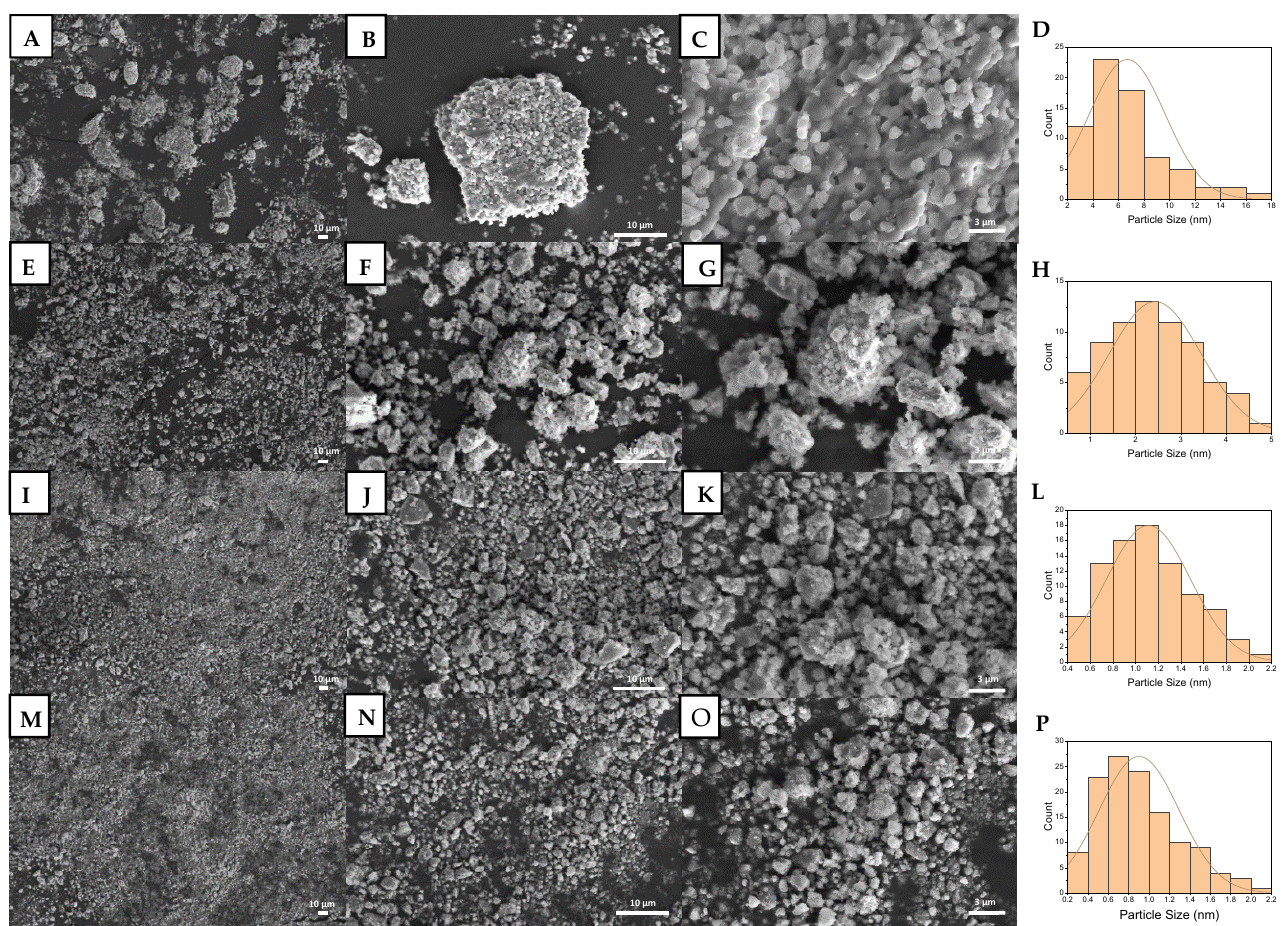
Figure 2. SEM images and particle size distribution of unmilled BHA ( A – D ), BHA milled for 3 h ( E – H ), BHA milled for 6 h ( I – L ), and BHA milled for 9 h ( M – P ). ( A , E , I , M ) Images show total magnification of 1000×. ( B , F , J , N ) Images show total magnification of 5000×. ( C , G , K , O ) Images show total magnification of 15,000×. ( D , H , L , P ) Graphs show the corresponding particle size distributions.